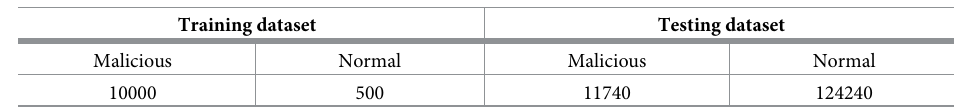
Table 3. Test and training dataset—Sperotto dataset.